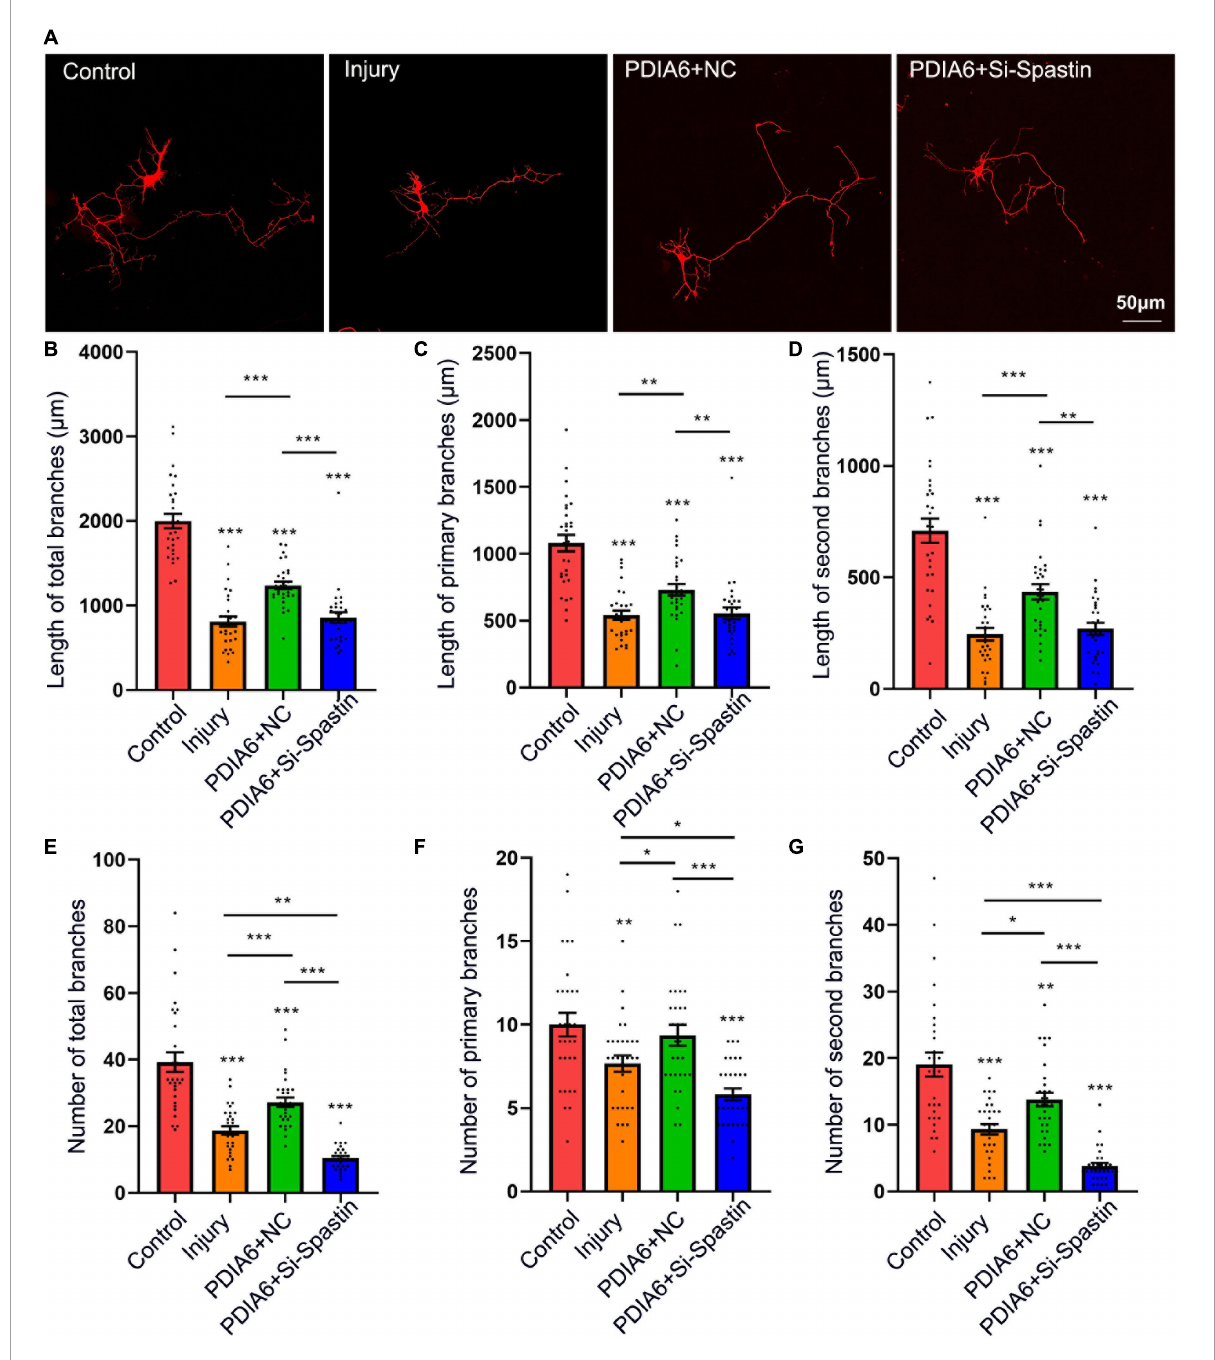
FIGURE5 PDIA6 interactions with spastin promote injured neuron repair. (A) Following culture in vitro for 3 days, glutamate (120 µ M) was used to injure hippocampal neurons. At 12 h post-injury, neurons were co-transfected for 24 h with Flag/NC, PDIA6/NC, or PDIA6/Si-Spastin. Scale bar: 50 µ m. (B–D) Total (B) , primary (C) , and secondary (D) branch lengths were measured, indicating that PDIA6 was able to promote the repair of injured neuron branches, while the silencing of spastin suppressed such PDIA6-mediated repair ( n = 30/group). (E–G) Total (E) , primary (F) , and secondary (G) branch numbers were quantified, indicating that PDIA6 promoted branch formation on injured neurons, whereas the knockdown of spastin inhibited this PDIA6-mediated repair ( n = 30/group). * P < 0.05, ** P < 0.01, *** P <